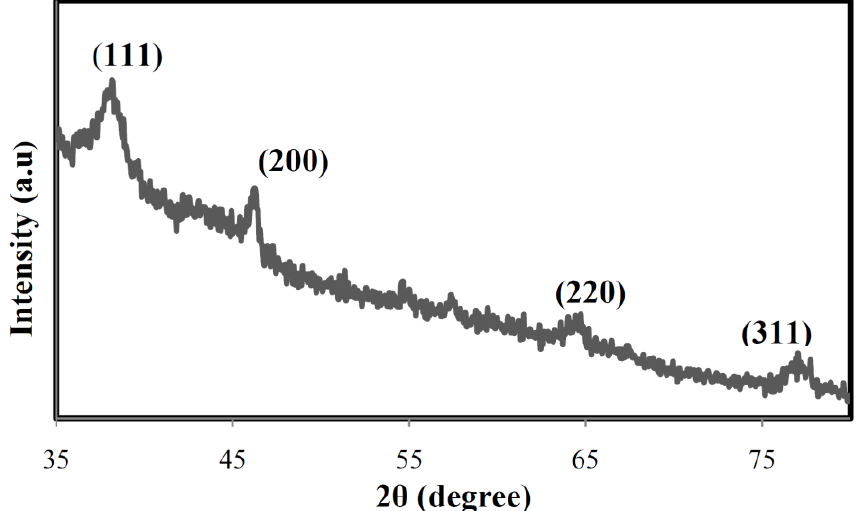
Figure 4. X-ray diffraction pattern of bio-synthesized Ag-NPs.